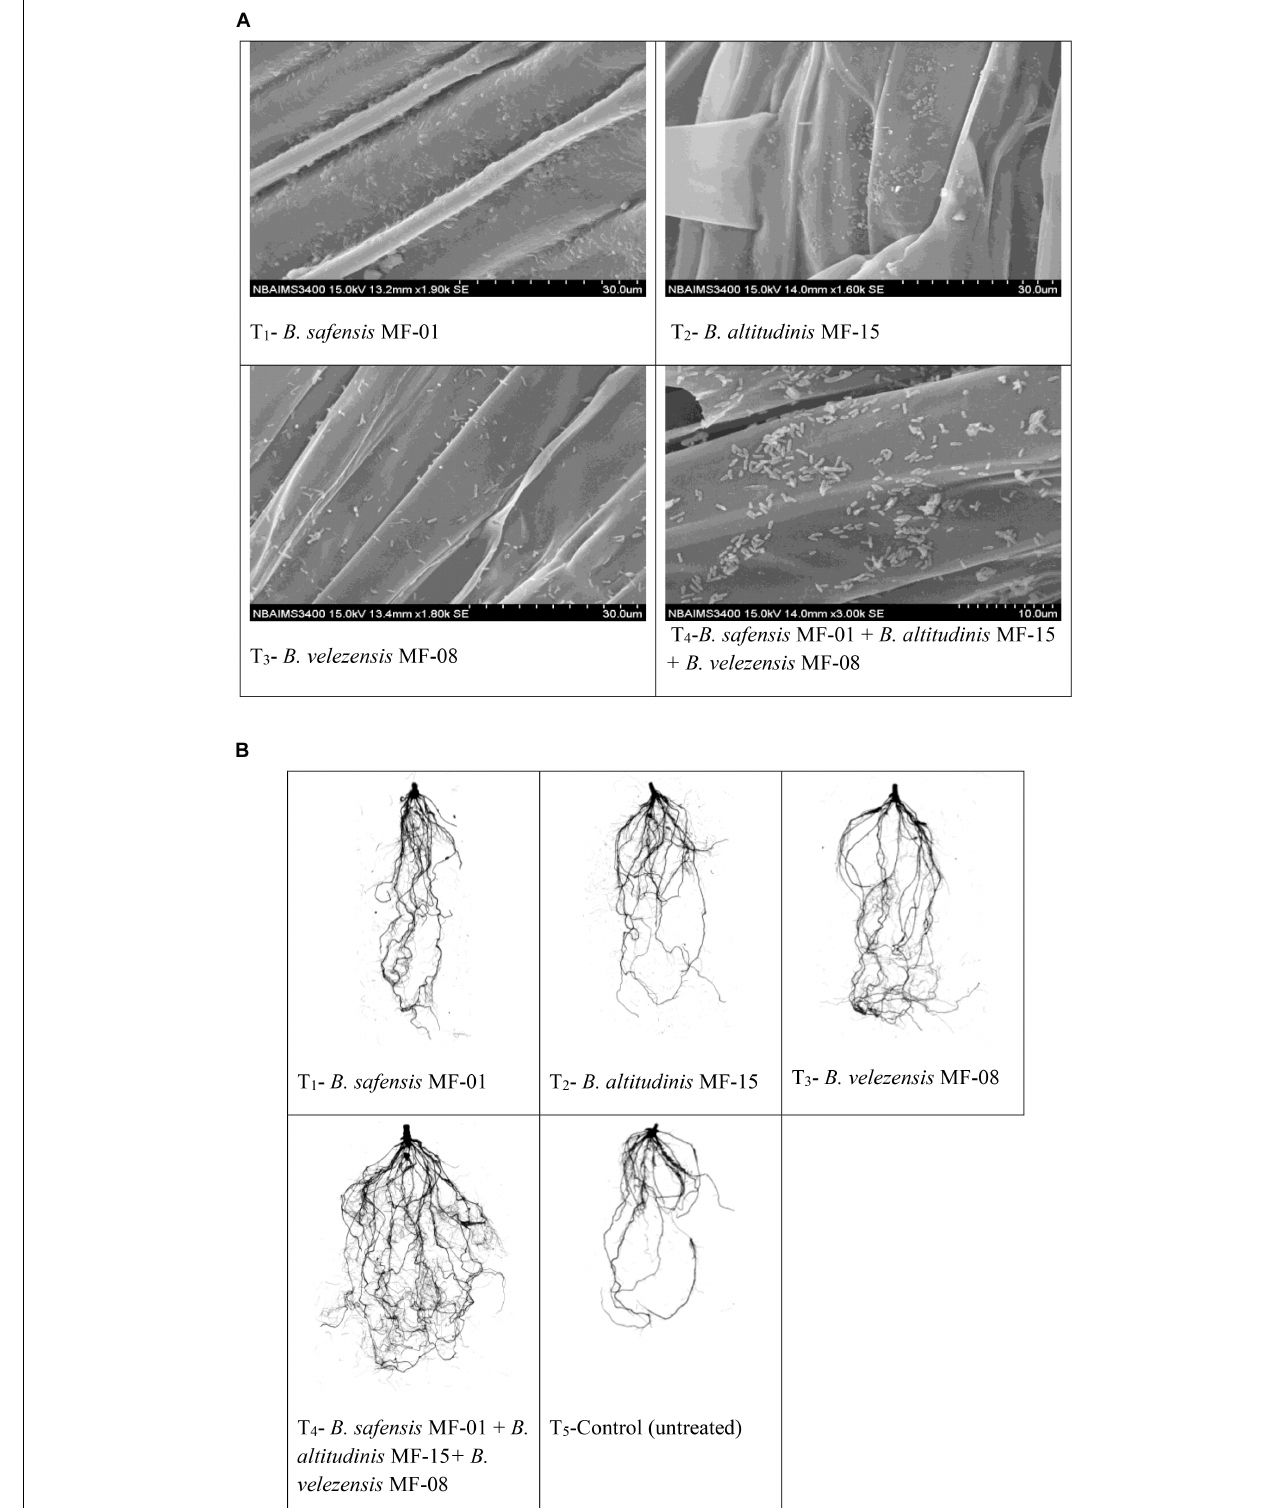
FIGURE 2 | (A) Scanning electron microphotographs showing root colonization by selected strains of Bacillus spp. at 30 days of sowing. (B) Effects of seed bio-inoculation on root growth and development in the maize grown in saline sodic soil at 30 days of sowing. Treatments were as follows: T 1 — B. safensis MF-01, T 2 — B. altitudinis MF-15, T 3 — B. velezensis MF-08, T 4 — B. safensis MF-01 + B. velezensis MF-08 + B. altitudinis MF-15, and T 5